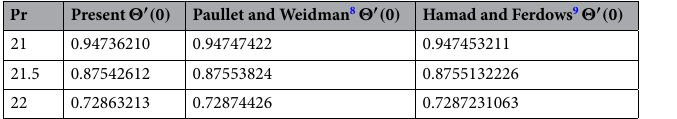
Table 4. Comparison with 8,9 considering integer order and common parameters. When (cid:31) = a b .